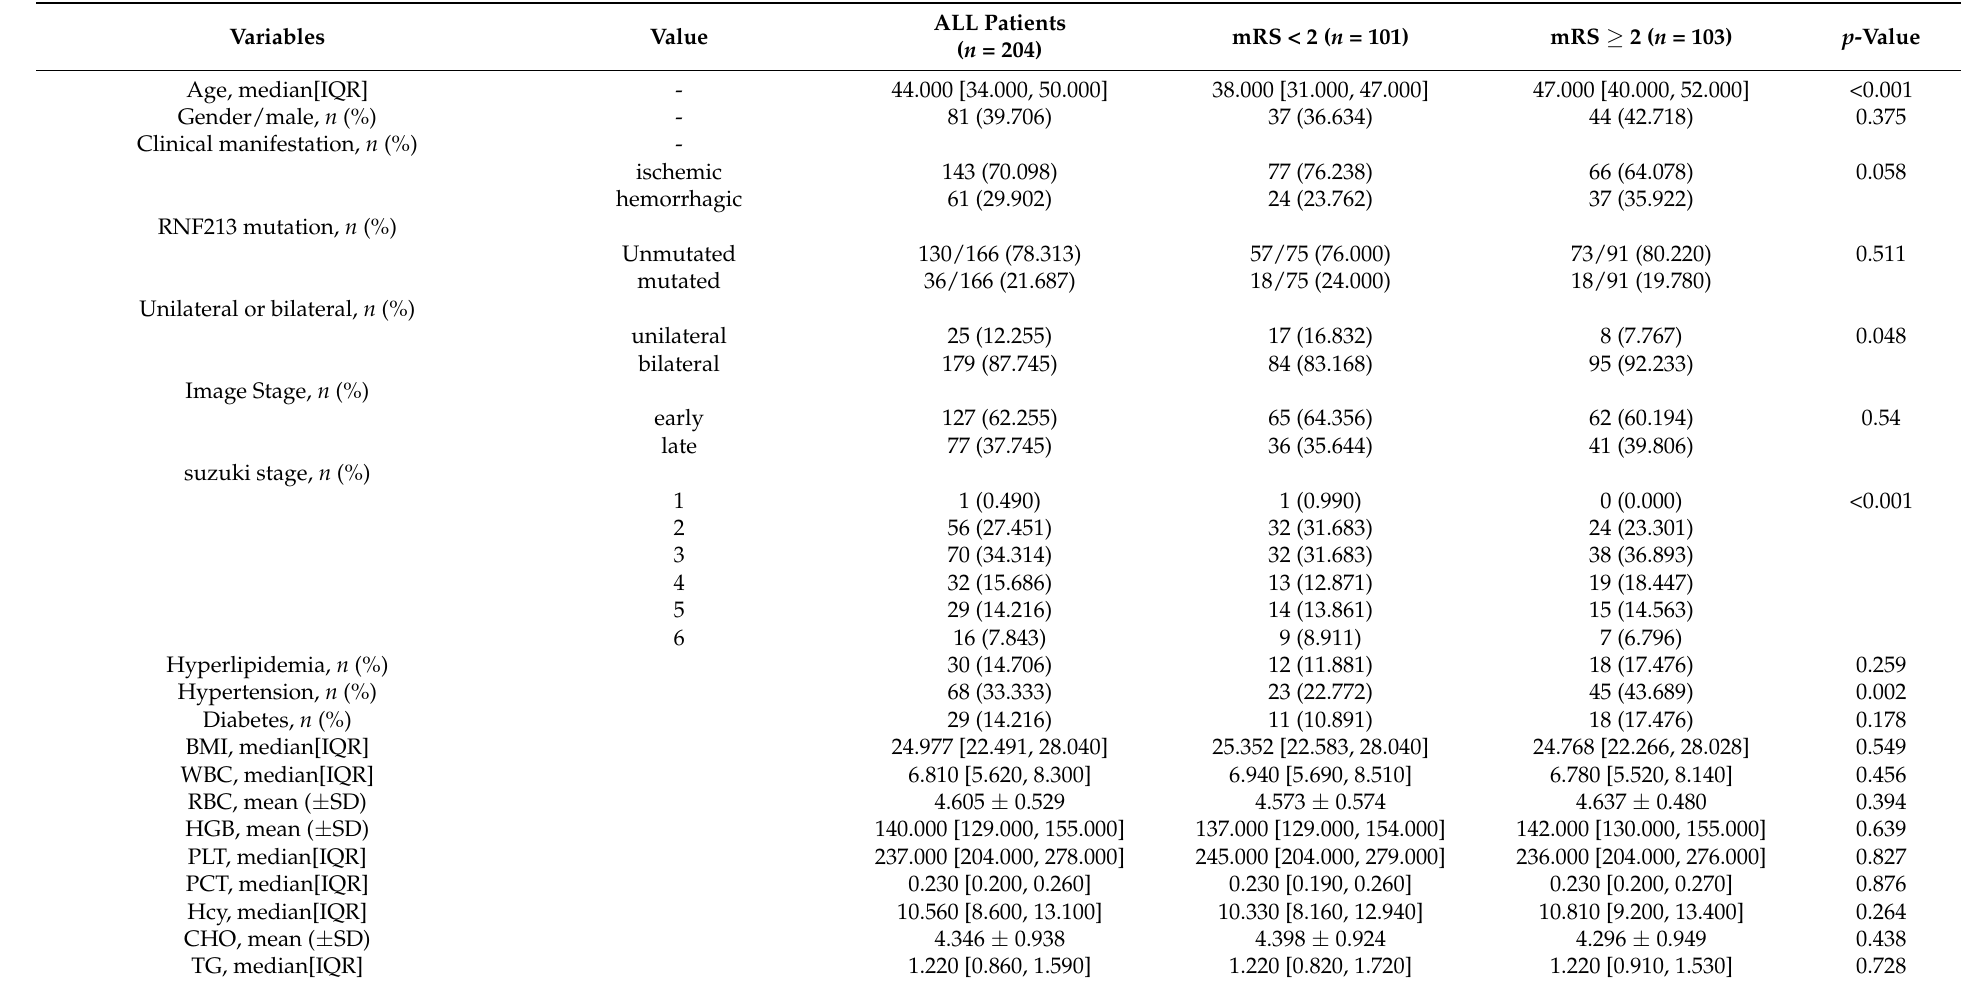
Table 1. Baseline characteristics of 204 patients with moyamoya